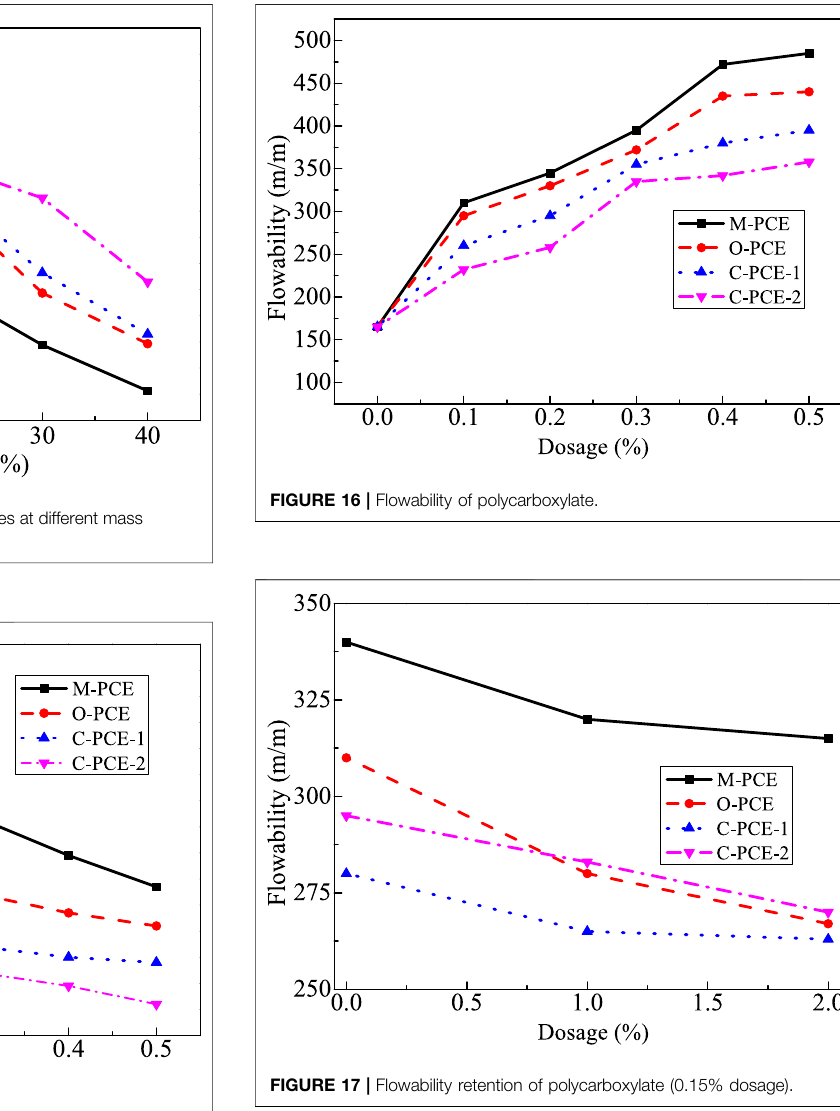
FIGURE 17 | Flowability retention of polycarboxylate (0.15%